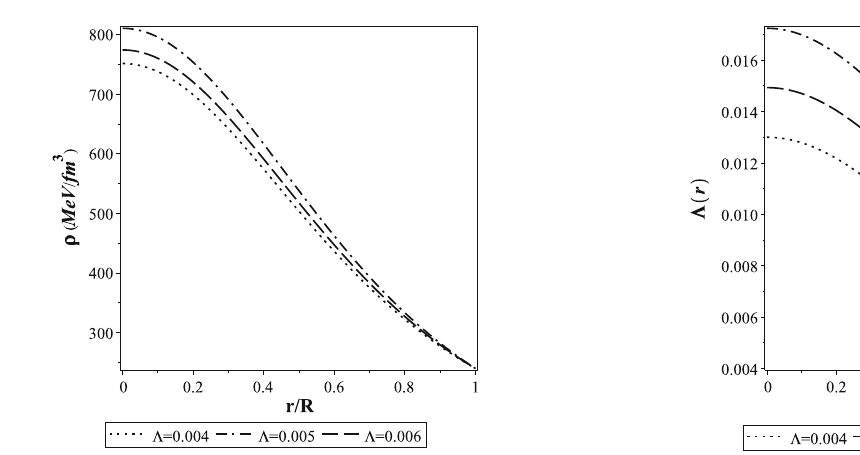
Fig. 1 Behaviorofdensityasafunctionofthefractionalradialdistance for the strange star candidate LMC X − 4 is shown. Here and in what follows B = 60 MeV / fm 3